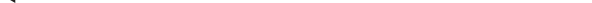
. Figure 3 Phylogenetic analysis of various CerS homeodomains. (A) The tree shows a bootstrapped parsimony Consense (Joseph Felsenstein, University of Washington, Seattle, USA) tree. Numbers